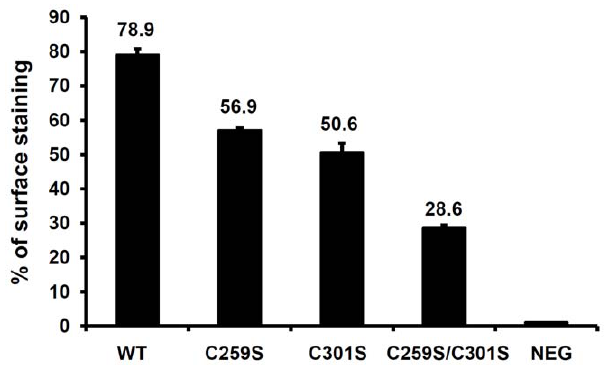
Figure 5. Cell surface expression of RAGE and RAGE cysteine- to-serine mutants. FLAG-tagged RAGE and RAGE mutants were transfected to CHO-CD14 cells. After overnight incubation, the transfected cells (10 6 ) were stained with anti-FLAG antibodies and subjected to flow cytometry analyses. Non-transfected cells with same staining were used as negative controls. All values were expressed as mean 6 SEM, and the data were from independent transfections ( n =3). The p value for presented data is , 0.01 (ANOVA).